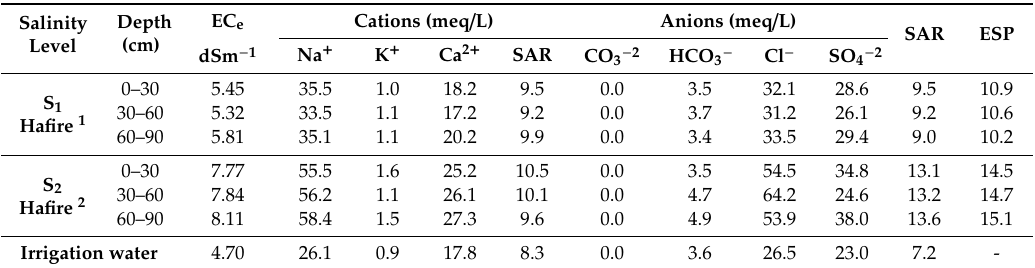
Table 4. Chemical properties of soil and irrigation water in the gypsum experimental sites. ESP: exchangeable sodium